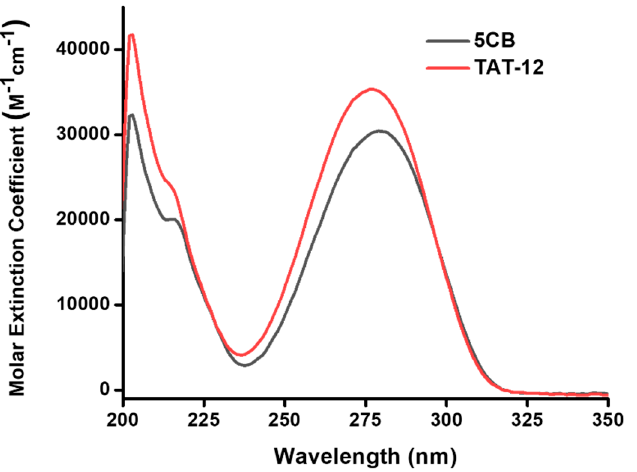
Figure 2. UV-Vis spectra of TAT-12 and 5CB in MeOH (10 − 5 M).